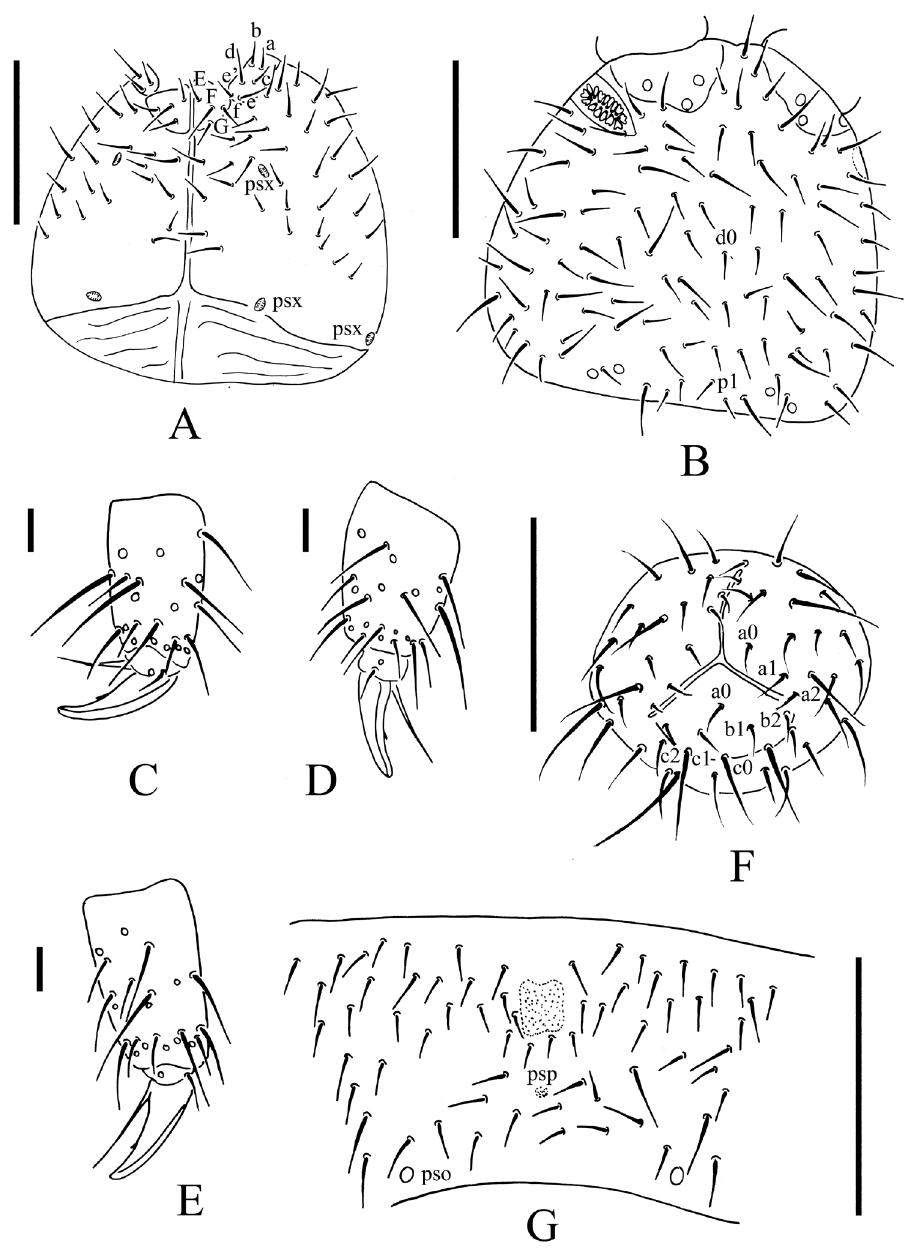
Figure 2. Uralaphorura liangshuiensis sp. n. A ventral side of head B dorsal side of head; C , distal part of leg I D distal part of leg II E , distal part of leg III; F, anal valves G Abd. sternum IV with furcal remnant. Scale bars: 0.1 mm A–B, F–G ; 0.01 mm C–E